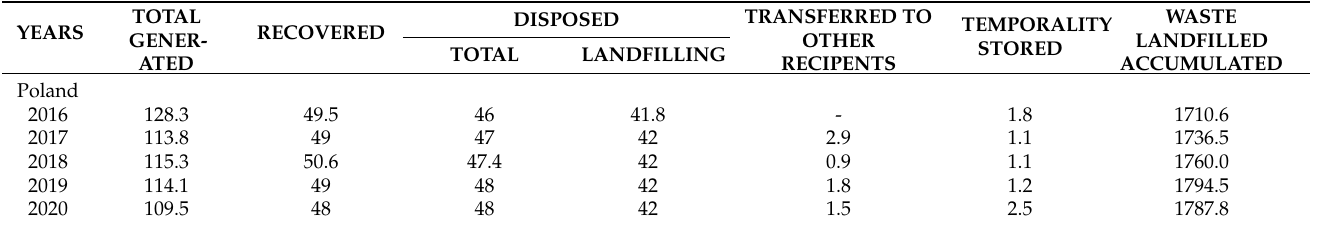
Table 6. Industrial waste generated and landfilled (million tonnes) and the structure of processing this waste (%) in Poland in 2016–2020 and UE-28 in